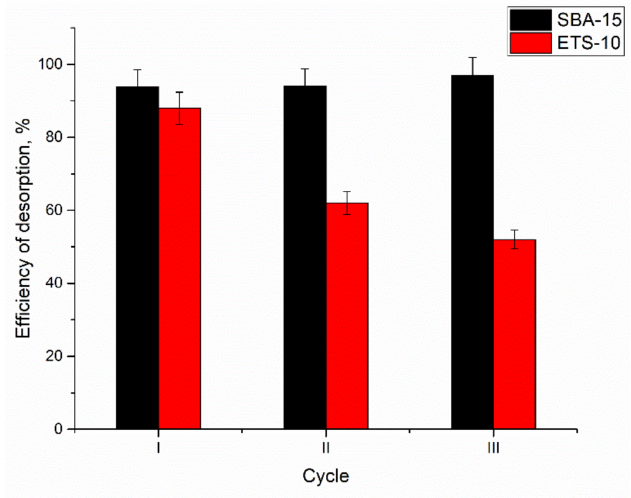
Figure 10. Desorption efficiency of silica SBA-15 and titanosilicate ETS-10